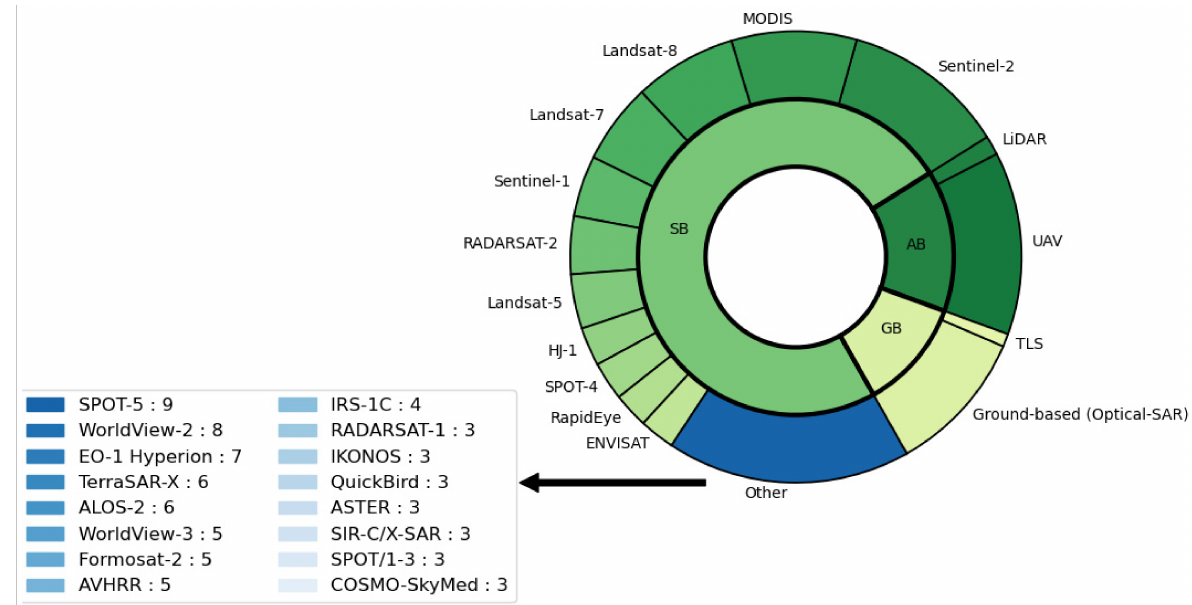
Figure 12. A detailed breakdown of remote sensing sensors used in screened